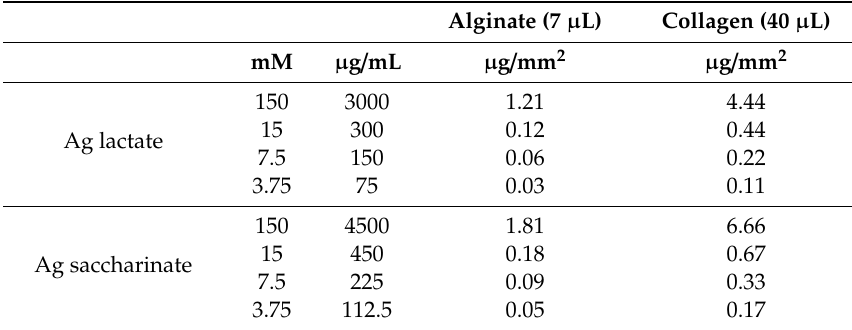
Table 1. Summary of the amount of silver contained in the